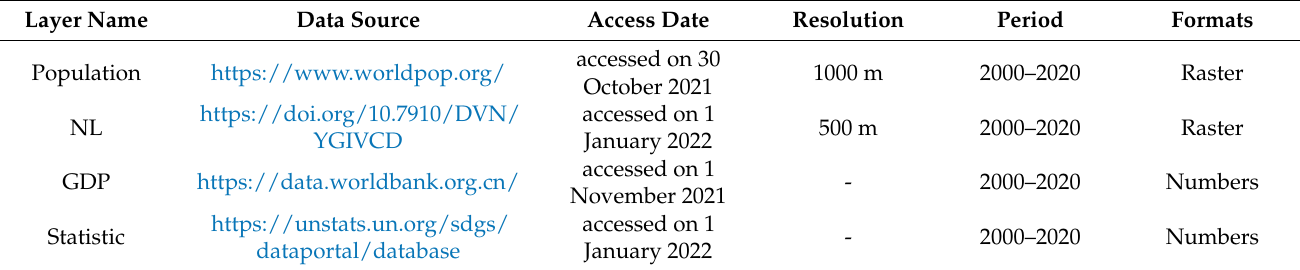
Table 1. The detail descriptions of the data and